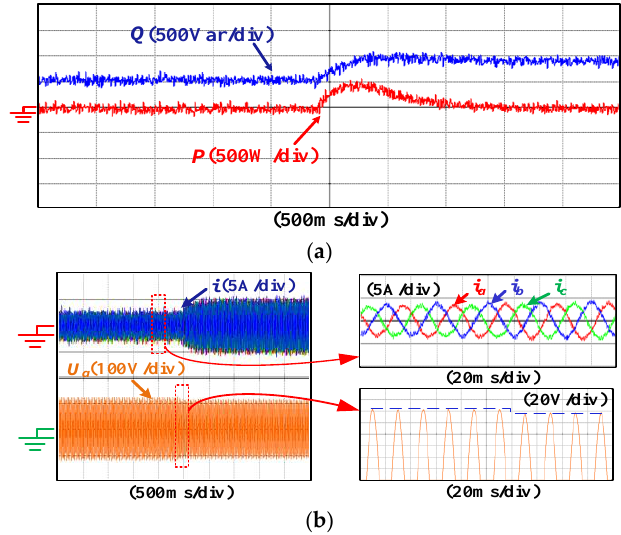
Figure 13. Experimental waveform of power and current when the voltage decreases. ( a ) Power mutation waveform when voltage decreases; ( b ) current mutation waveform when voltage decreases.